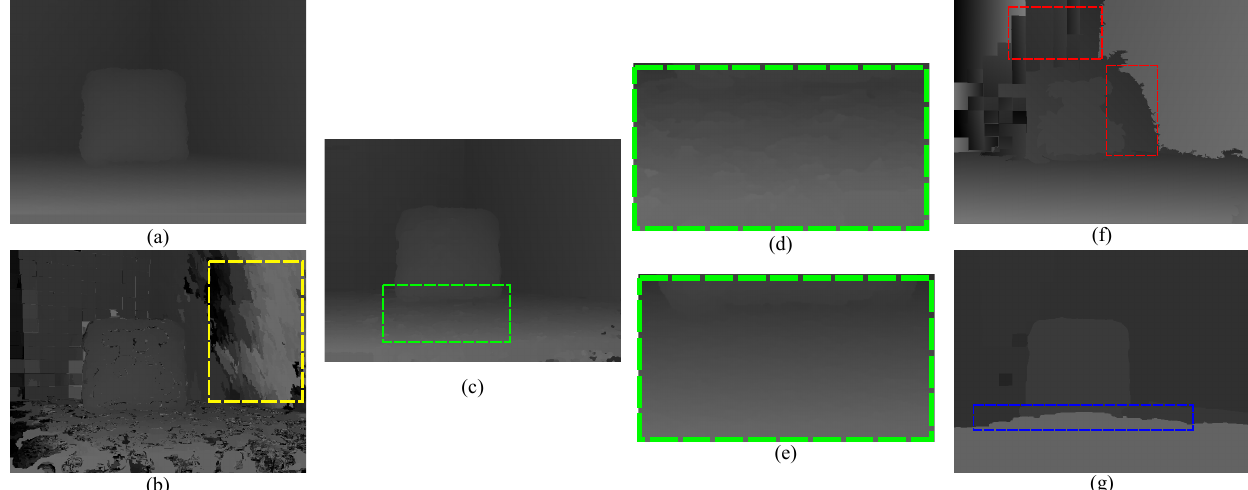
Figure 16. Evaluation results when turning off some terms. ( a ) Our result; ( b ) result without the texture term; ( c ) result without the improved luminance consistency term; ( d ) the detail with an enlarged scale in the green region of (c); ( e ) our result detail with enlarged scale in the same green region of (c); ( f ) result without the hybrid smoothness term; ( g ) result without the 3D plane bias term. Nonocc: non-occlusion